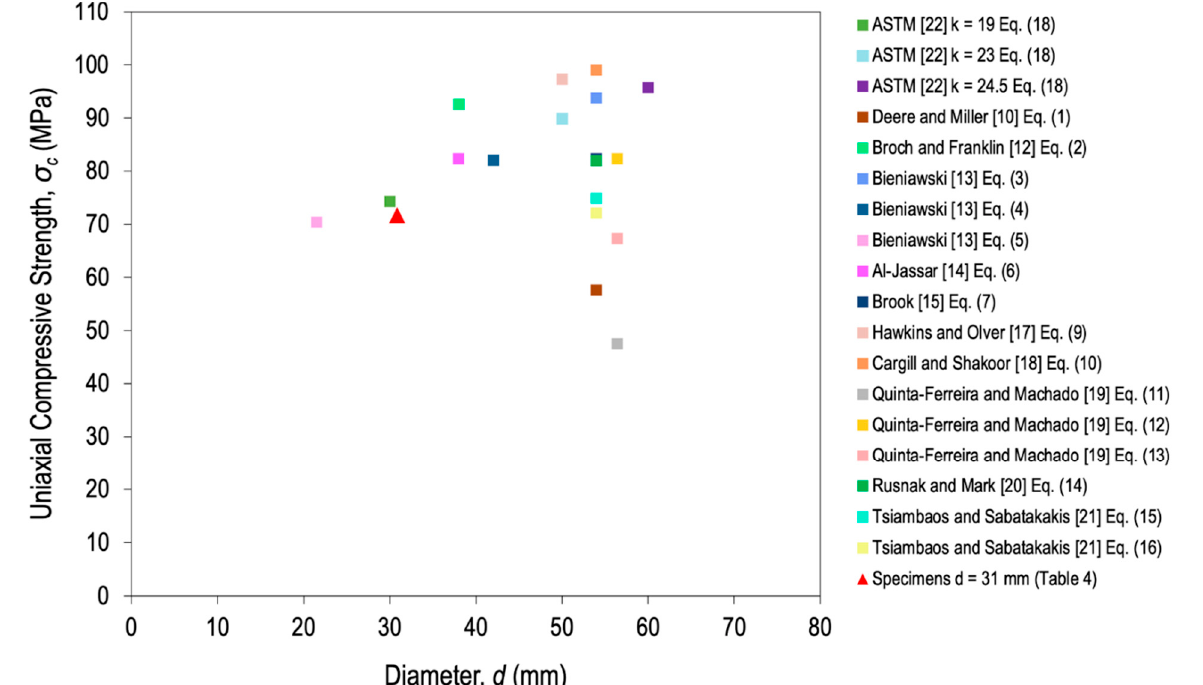
Figure 6. Estimation of σ c from the correlations with I s , I s (50) , and I s (50) of Table 1 for limestone.